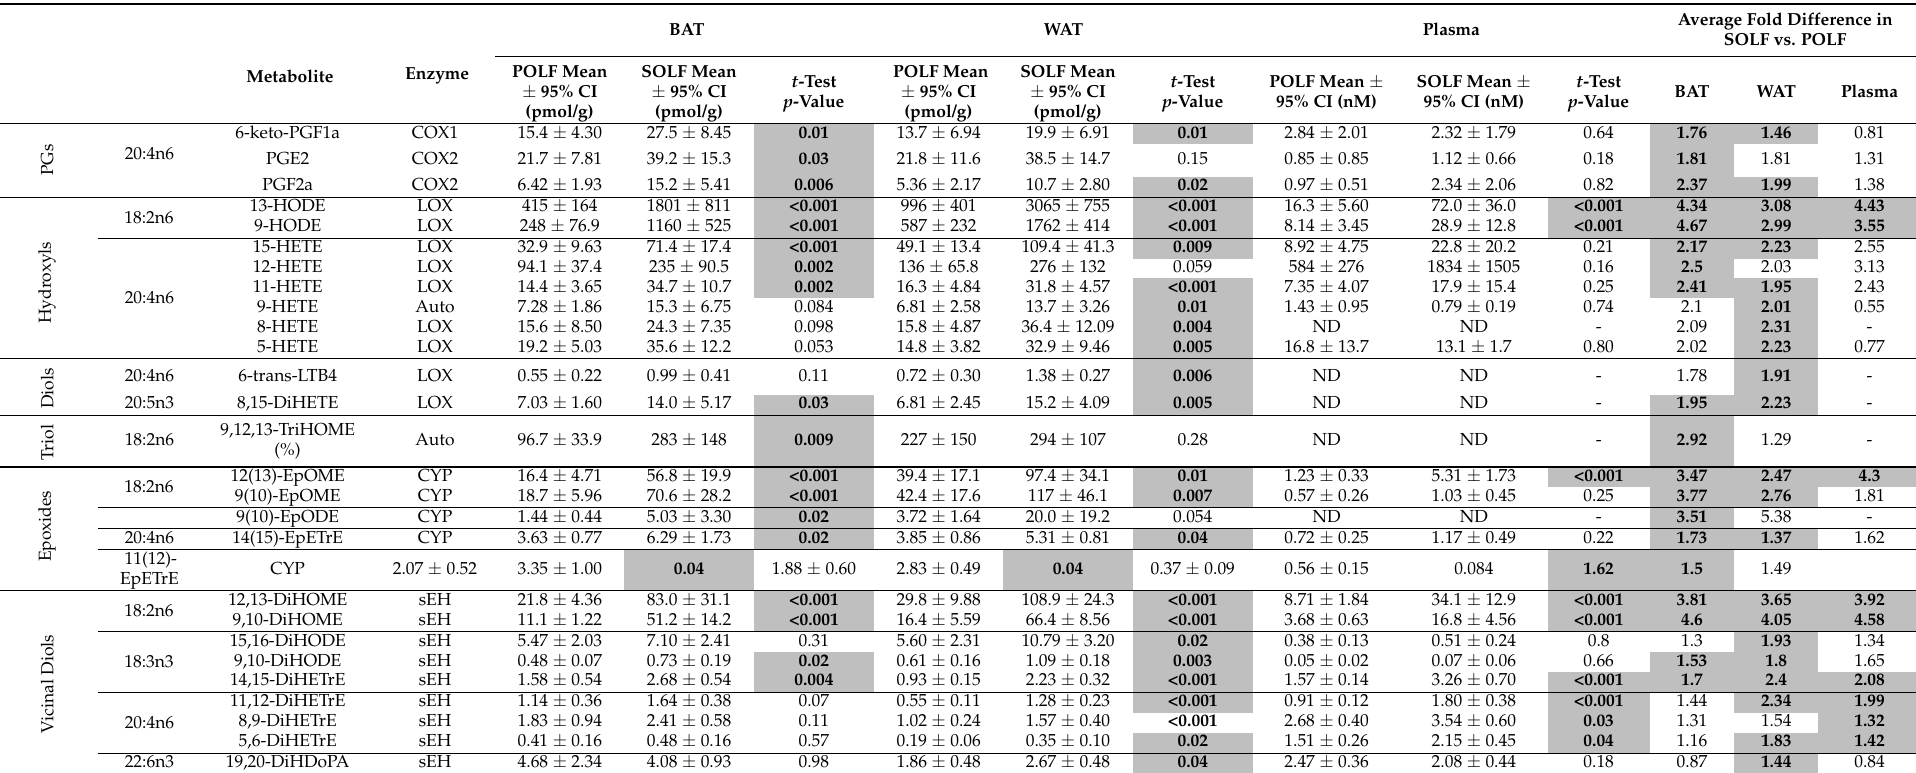
Table 1. ( Part 1 of 2 ). Lipid mediators altered by diet in BAT, iWAT, and plasma of mice consuming POLF and SOLF diets. ( Part 2 of 2 ) Lipid mediators altered by diet in BAT, iWAT, and plasma of mice consuming POLF and SOLF diets. Targeted lipidomics was used to identify lipid mediators altered by diet in BAT, iWAT, and plasma. Tabulated are all oxylipins exhibiting significant differences between diet groups in at least one measured tissue, grouped by class and parent fatty acid. Student’s t -tests were used to compare the mean oxylipin concentration between diet groups on log-transformed data, with bold values in grey boxes indicating significant differences ( p < 0.05). Average fold differences were calculated by dividing the average metabolite value for the SOLF diet group by that of the POLF diet group. N = 7–9 mice per group. ND = not detected or low abundance (>25% missing values). Enzymatic pathway abbreviations: